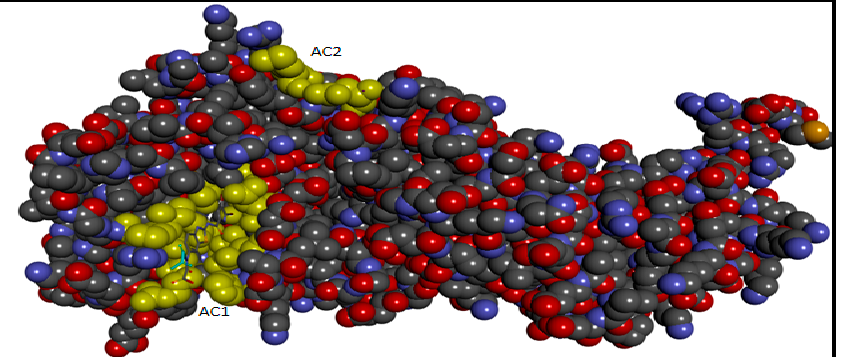
Figure 7. The Crystal structure of DNA gyrase (PDB ID 5L3J) showing two active sites AC1 and